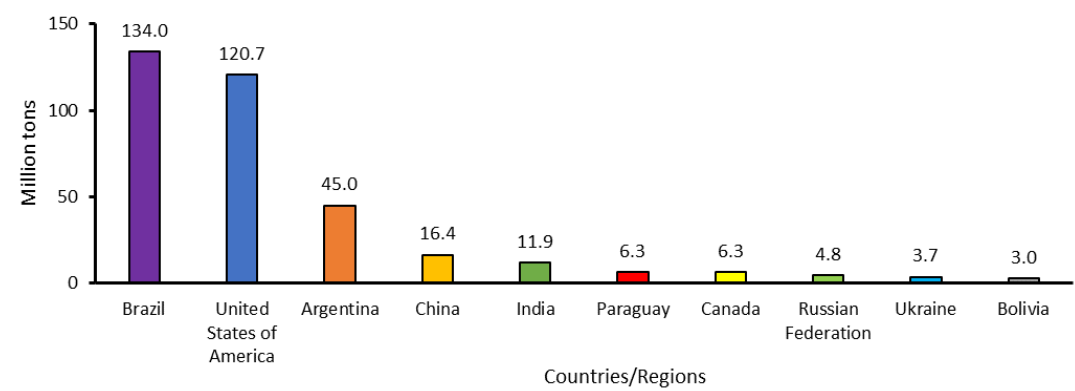
Figure 2. Production volumes of soybean in the top 10 producing countries/regions in 2021. Data were retrieved from USDA (https://ipad.fas.usda.gov/cropexplorer/Default.aspx) on 1 March 2022.